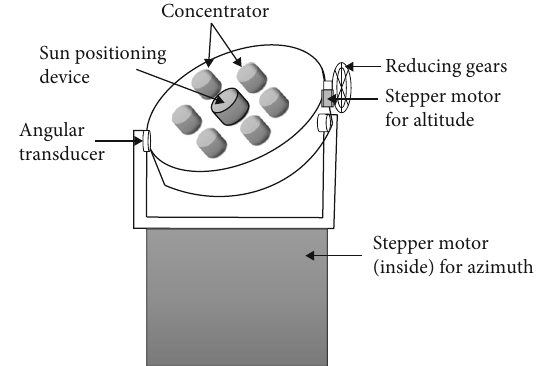
Figure 9: Active daylighting system consisted of dual-axis sun- tracking and concentrating system (source: adapted from